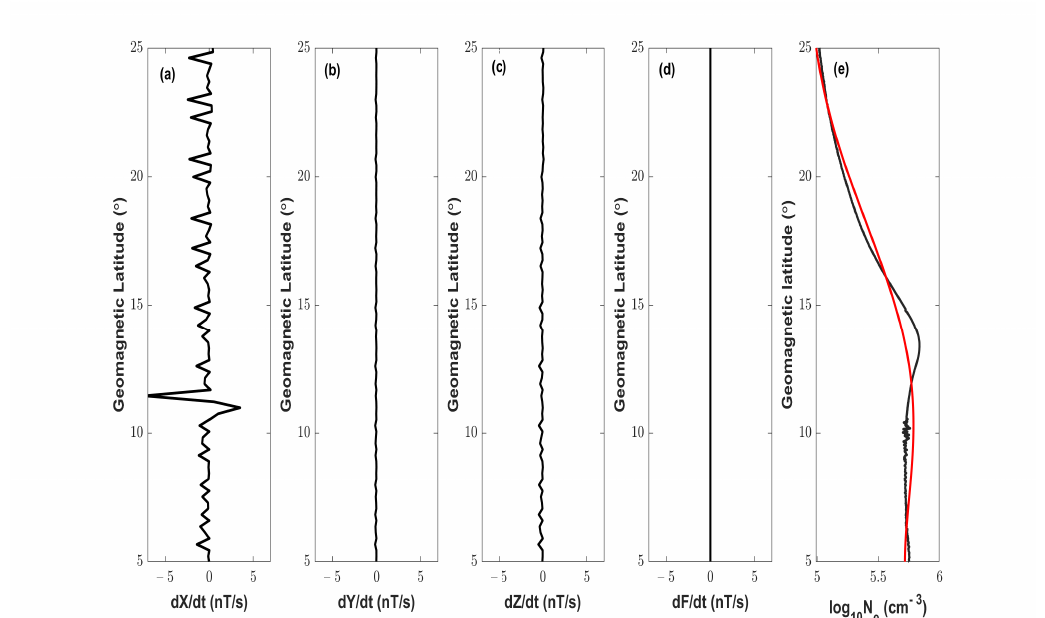
Figure 17. Comparison of magnetic filed anomaly from MASS with the electron density profile as obtained from NeLOG algorithm in the track number 15 of SAT-C. Geomagnetic latitude variation of rate of change of magnetic field in ( a ) X-component, ( b ) Y-component, ( c ) Z-component, ( d ) scaler component (F). ( e ) In the fifth panel, the black line shows the original Log 10 (N e ) variation, and the red line indicates the polynomial fitted curve.